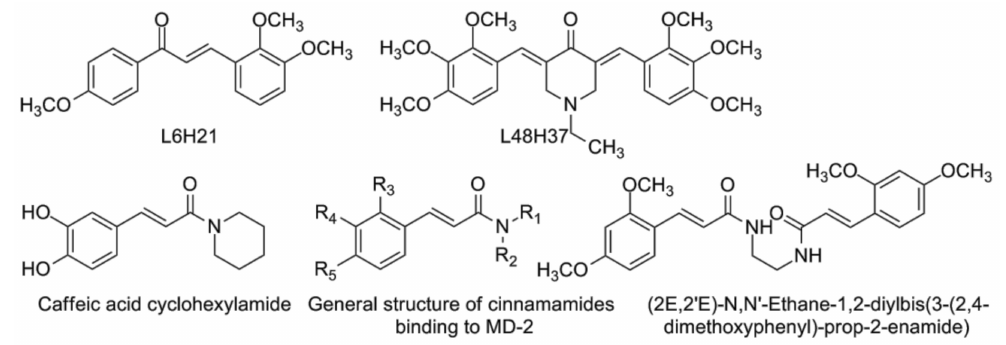
Figure 7. Chalcone L6H21, curcumin analogue L48H37 (upper row, from left to right), caffeic acid cyclohexylamide, general structure of synthesized cinnamamides, and the most active compound (from left to right, lower